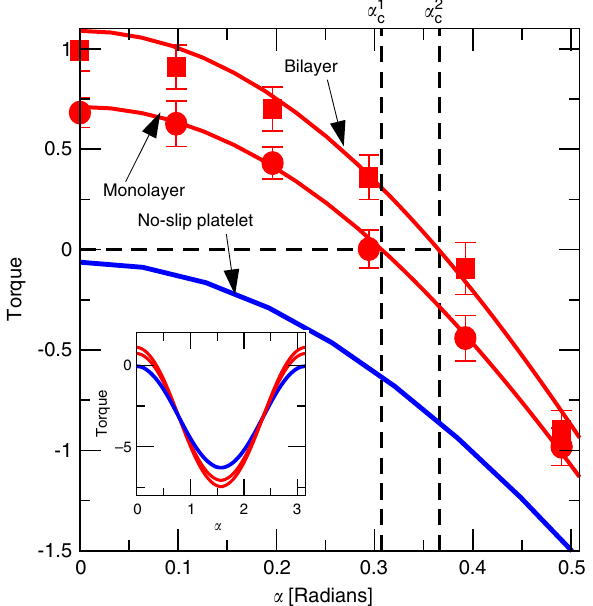
Fig. 3 Torque versus platelet orientation. Non-dimensional hydrodynamic torque T = ð a 2 w _ γη Þ versus platelet inclination angle α . Symbols correspond to MD simulations for a monolayer with aspect ratio b / a = 0.15, half length a = 1.7 nm and slip length λ = (60 ± 5) nm (disks) and a bilayer with aspect ratio b / a = 0.25, half length a = 1.7 nm and slip length λ = (60 ± 5) nm (squares); red lines are BI calculations for the corresponding values of λ / b and b / a . Error bars correspond to the standard deviation from 10 simulations of 0.4 ns. The dashed lines mark the inclination angle α c for which the hydrodynamic torque is zero. The blue line corresponds to BI calculations in the case of a monolayer with no-slip boundary condition. Insert: Torque vs platelet inclination angle for α ∈ [0, π ].